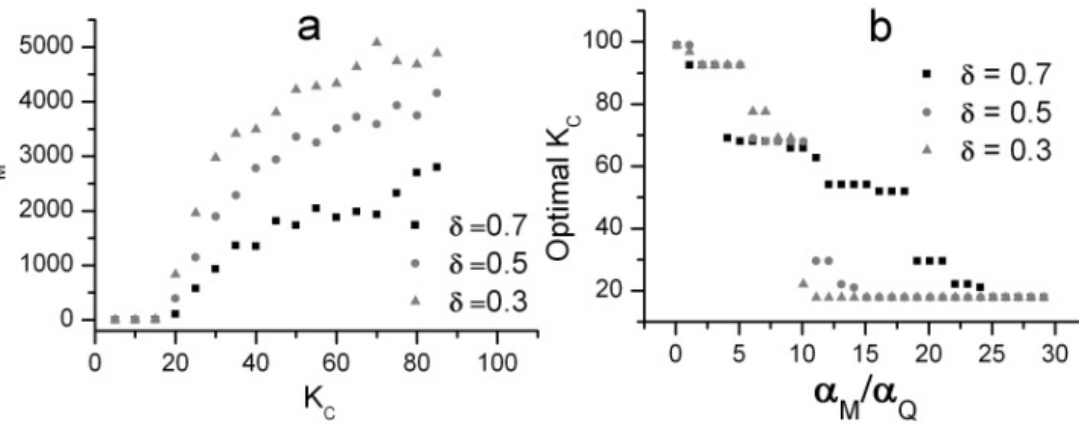
Figure 3: (a) The counted total number of places under control in the first 200 days since the outbreak, with di ff erent K C and δ . (b) The optimal K C , which minimizes total cost for containing the pandemic influenza outbreak C M + C Q , with di ff erent α M /α